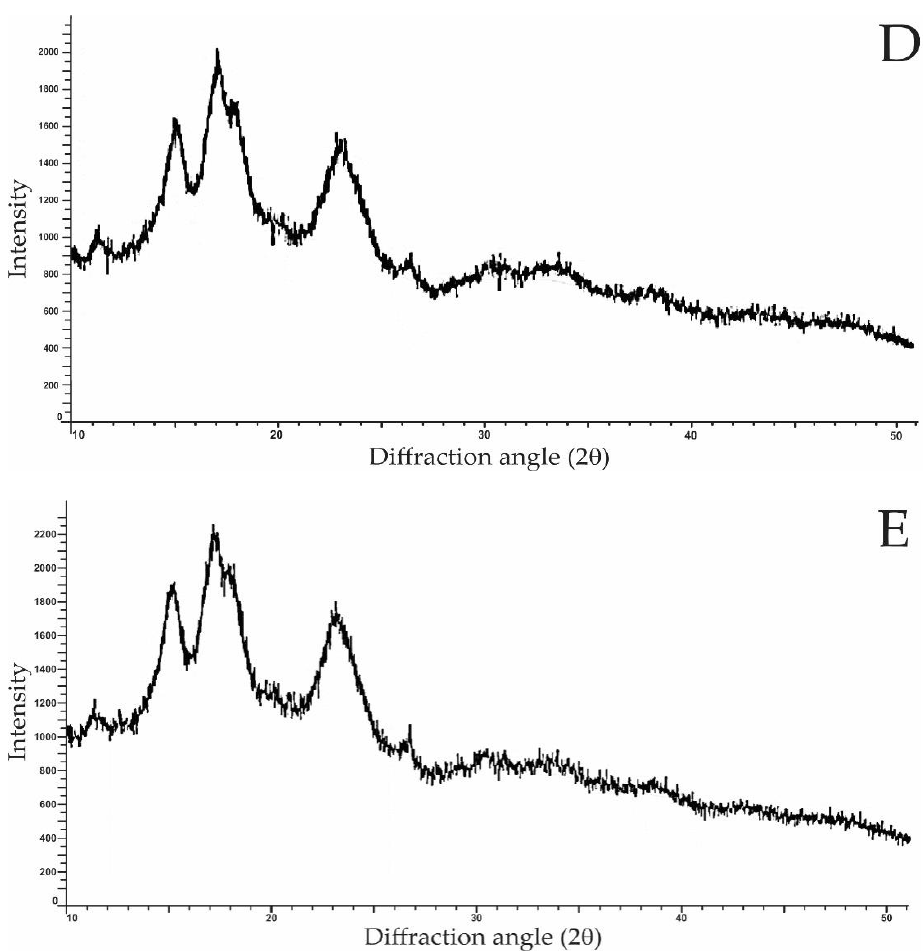
Figure 4. XRD spectra of native and modified lotus rhizome starches ( A ) — Native; ( B ) — MI; ( C ) — IR; ( D ) — MI-IR; ( E ) — IR-MI.